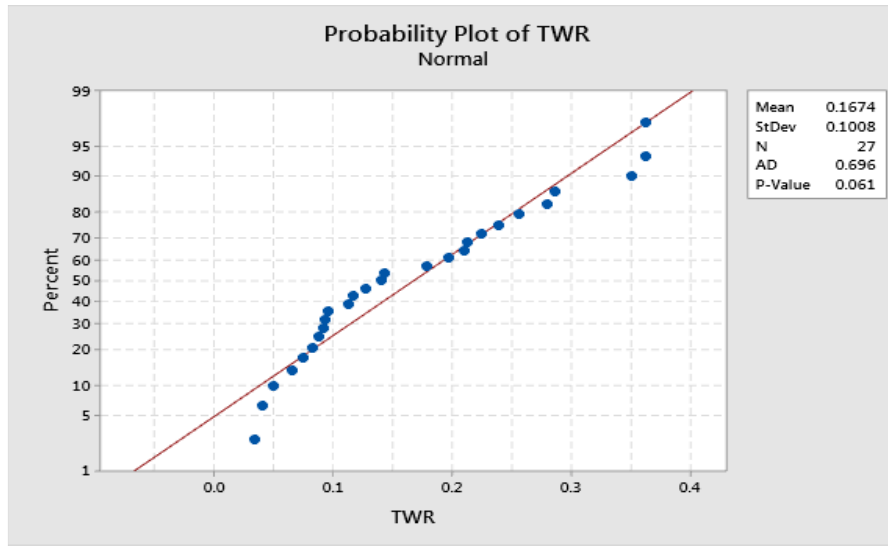
Figure 7. Normal probability plot of residuals for